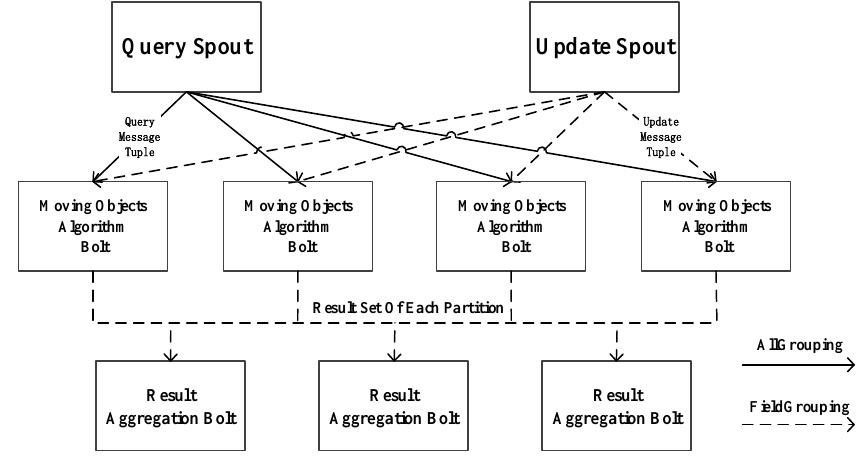
Figure 2. Storm topology for a single dataset.